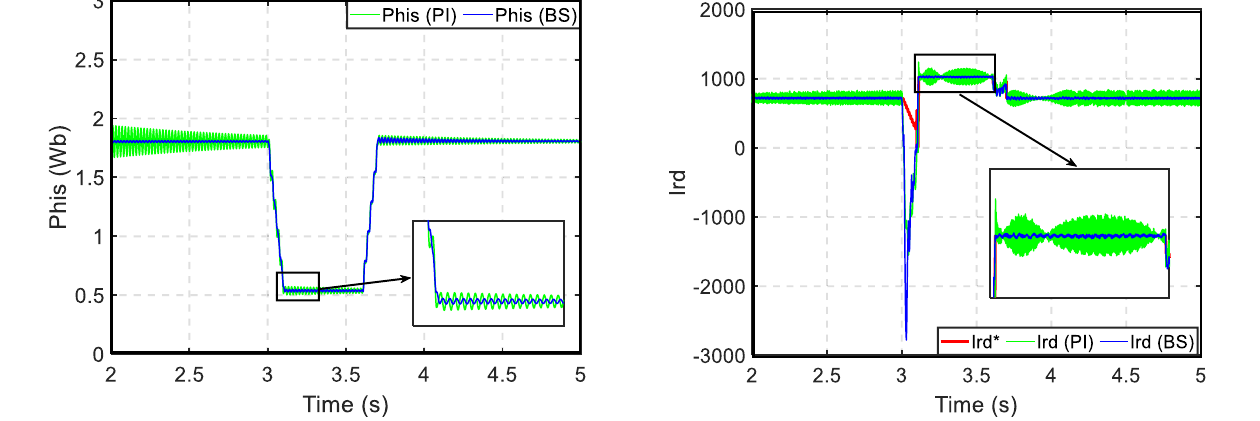
Fig. 19 Stator flux module evolution